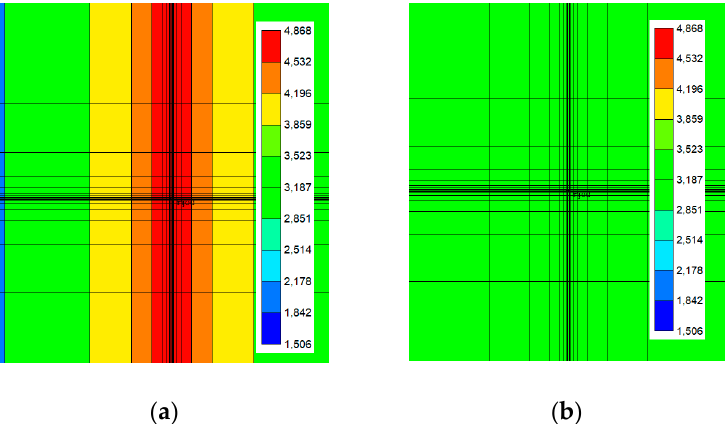
Figure 20. Pressure distribution near the fracture, injection pressure: 5000 psi; ( a ) start of soaking time; ( b ) end of soaking time.